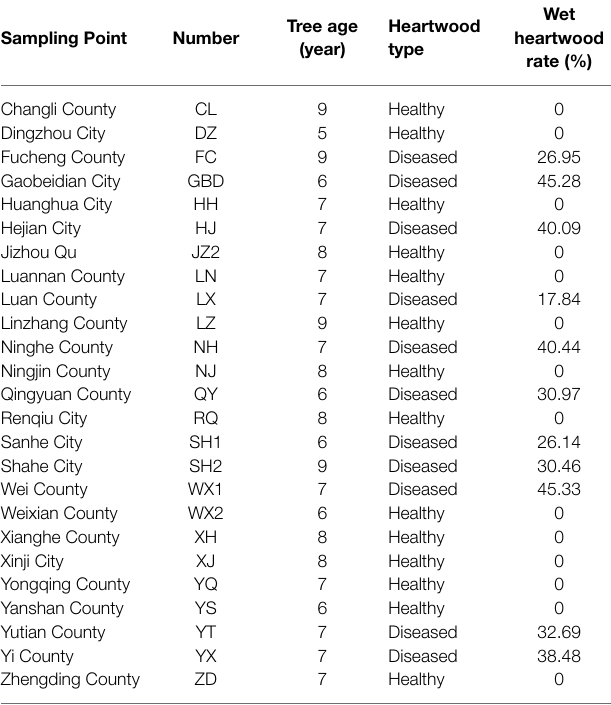
FIGURE 1 | Distribution of the sampling sites. The color of the sampling point icon indicates the size of the wet heartwood rate at that site. The smaller the wet heartwood percentage, the bluer the color of the icon, the higher the wet heartwood percentage, and the redder the color of the icon.